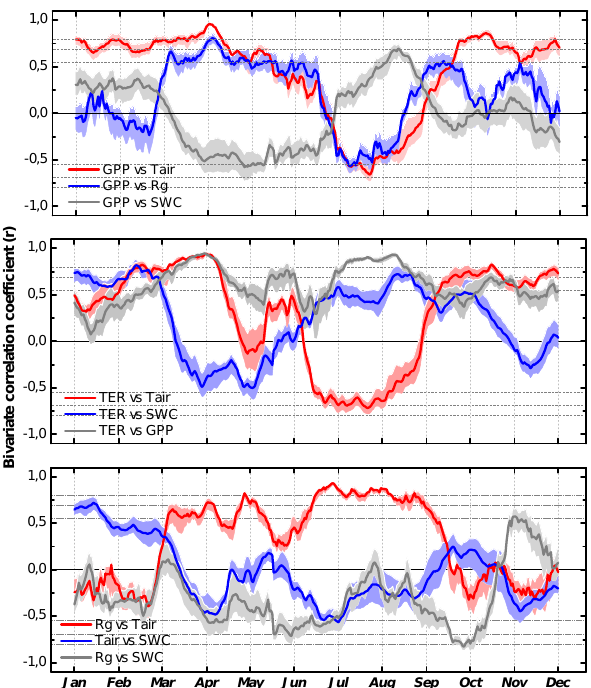
Fig. 2. Bivariate correlations between: (a) periodical GPP in- tegral (30-day moving window) with periodical mean air temper- ature ( T air ), soil water content (SWC) and global radiation ( R g ). (b) : periodical TER integral with periodical mean climate variables and GPP. (c) : the climate variables. Dashed horizontal lines indi- cate different levels of statistical significance ( p = 0 . 05, 0.01 and 0.001). The shaded area indicates the uncertainties (75 percentile) of the correlation coefficients, as data of each individual year was excluded from the correlation analysis.